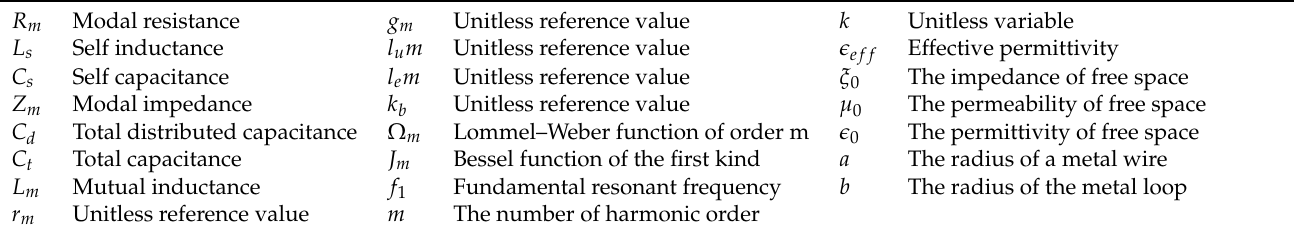
Table 2. Symbols in